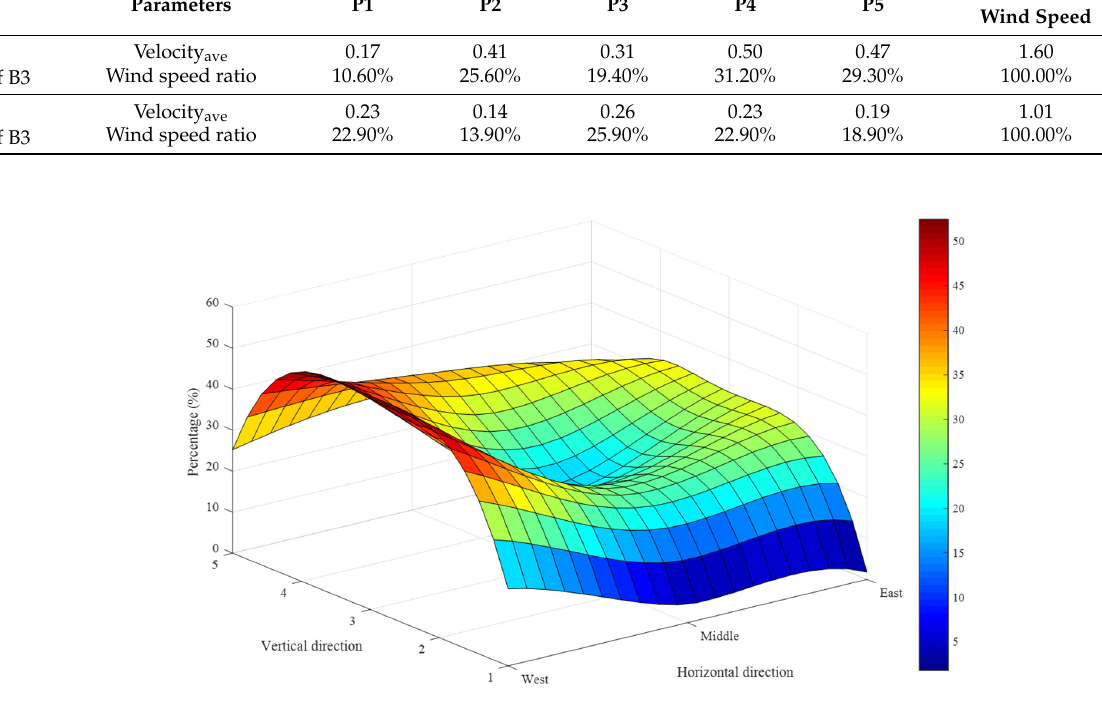
Figure 12. Airflow velocity of B3 in summer.